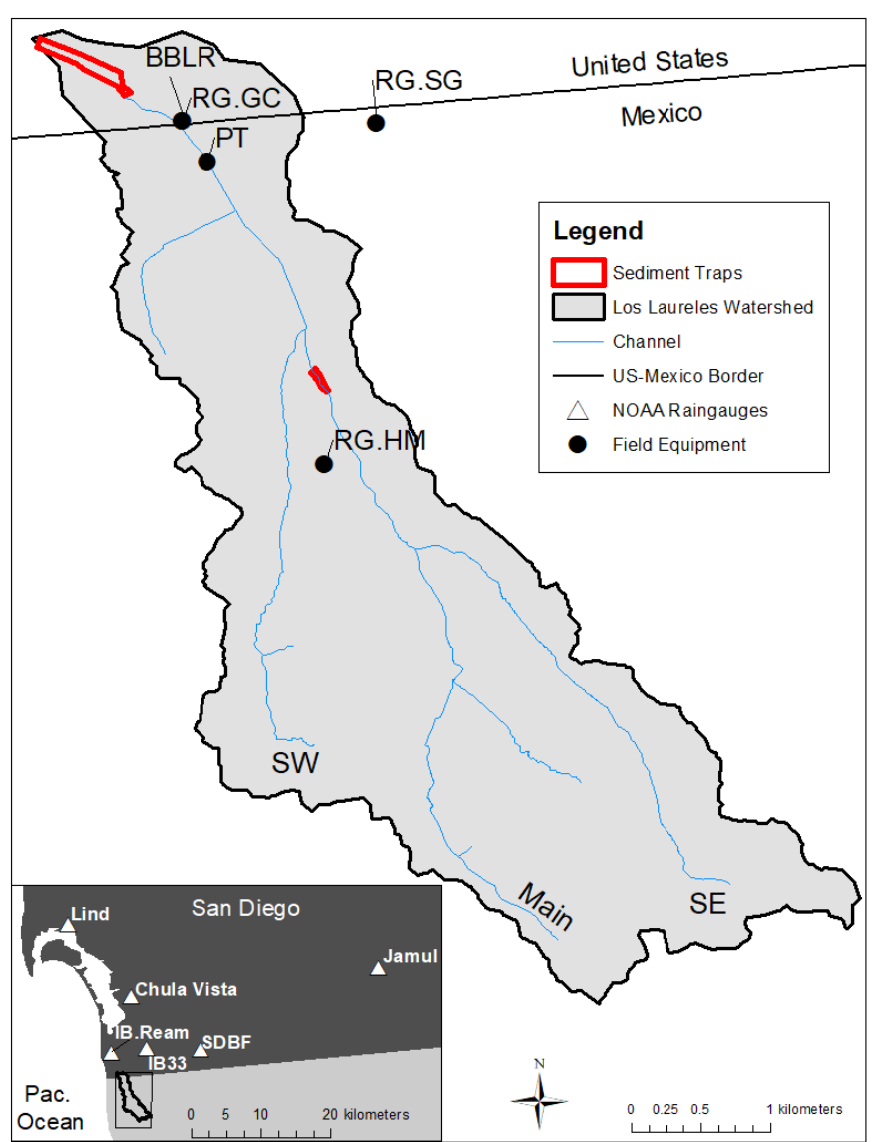
Figure 1. Location of the Los Laureles Canyon Watershed, main channels (SW, Main, and SE), and monitoring stations including sediment traps and rain gauges (RG). Inset shows the geographic locations of nearby rain gauges used in this analysis to span the rainfall time series.